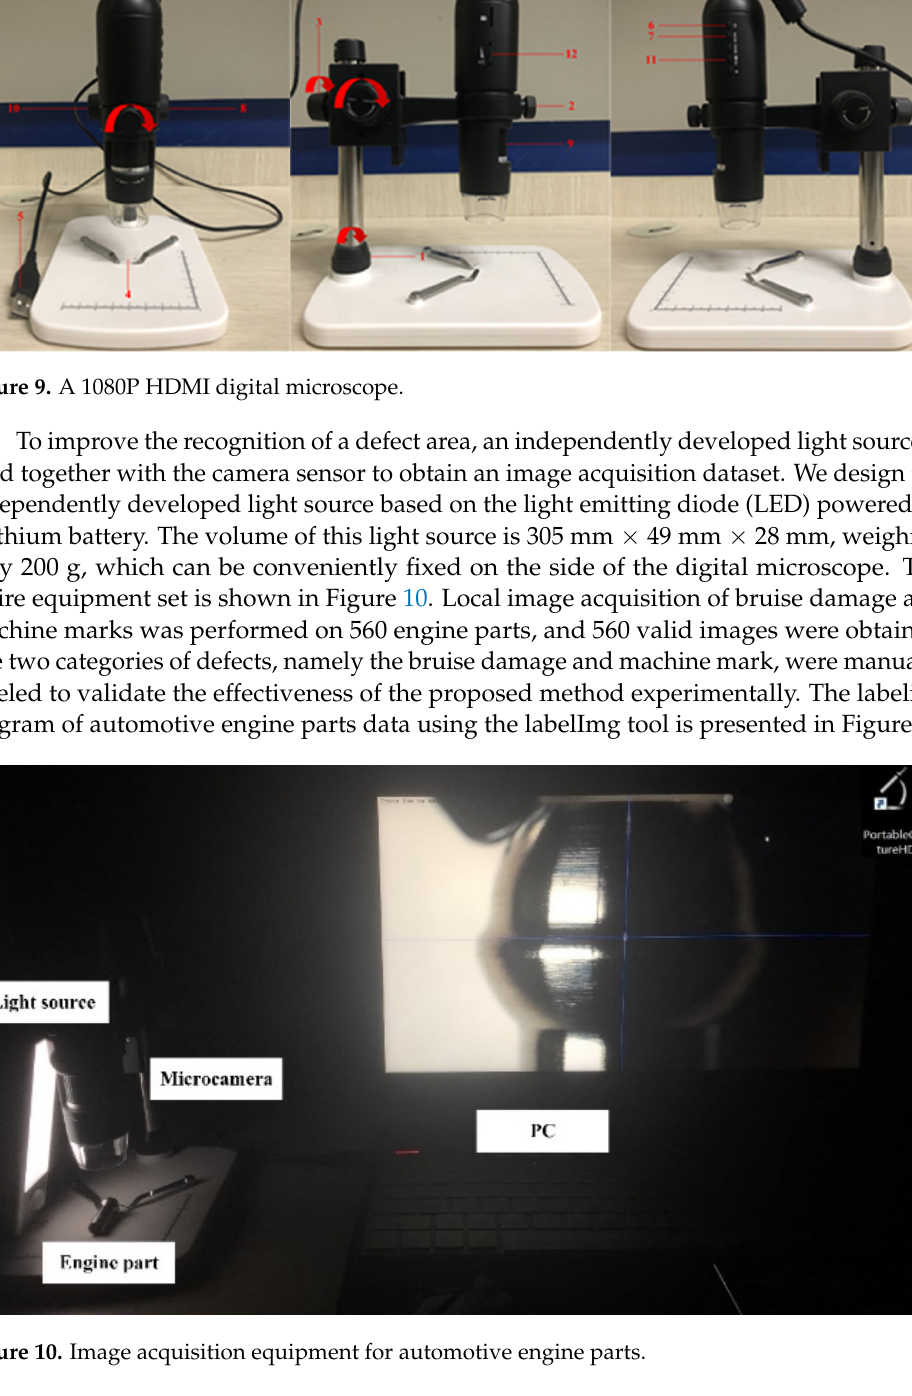
Figure 11. LabelImg of automotive engine parts data. 3.2. Quantitative Analysis To verify the effectiveness of the improved anchor points, after the dataset was con- structed, 500 randomly selected labeled images were used for training, and the remaining 60 labeled images were used for testing. The surface defect detection accuracies of auto- motive engine parts of the Faster R-CNN, Mask R-CNN, and proposed IA-Mask R-CNN models were tested. Due to the limitation of the GPU memory, the batch size in the exper- iment was set to one. The VGG16 and ResNet101 were first pre-trained on the COCO da- taset that contained 80 image categories [22]. The networks were then fine-tuned using the pre-training weights and, finally, the Faster R-CNN was iterated 80,000 times and the Mask R-CNN and IA-Mask R-CNN were iterated 10,000 times. The quantitative results are shown in Table 3. By quantitatively comparing the results of the three detection models, it was ob- served that, after adding the mask branch, the Mask R-CNN and IA-Mask R-CNN per- formed better in detecting surface defects of automotive engine parts than the Faster R- CNN and required a shorter training time. In addition, the number of iterations had de- creased, and a higher precision was achieved with the support of the ResNet101. After improving the anchor scales, the IA-Mask R-CNN did not require additional training pa- rameters compared to the Mask R-CNN. Under the same pre-training model, training